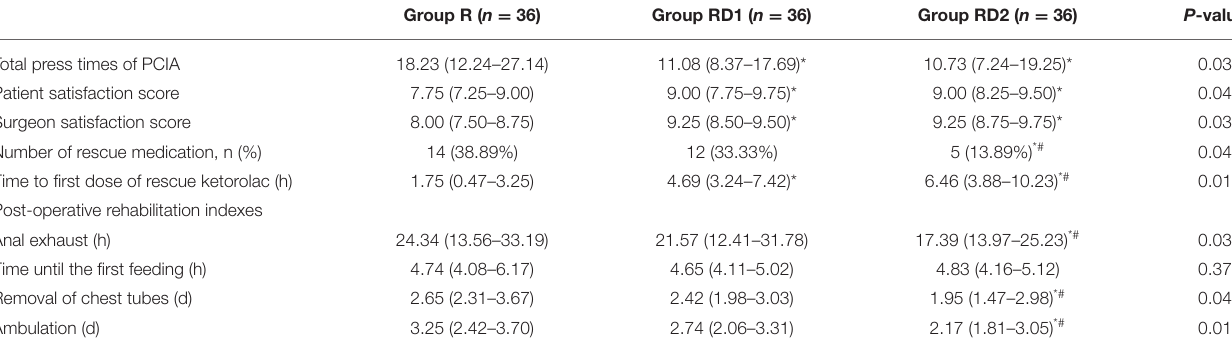
TABLE 3 | Post-operative variables.